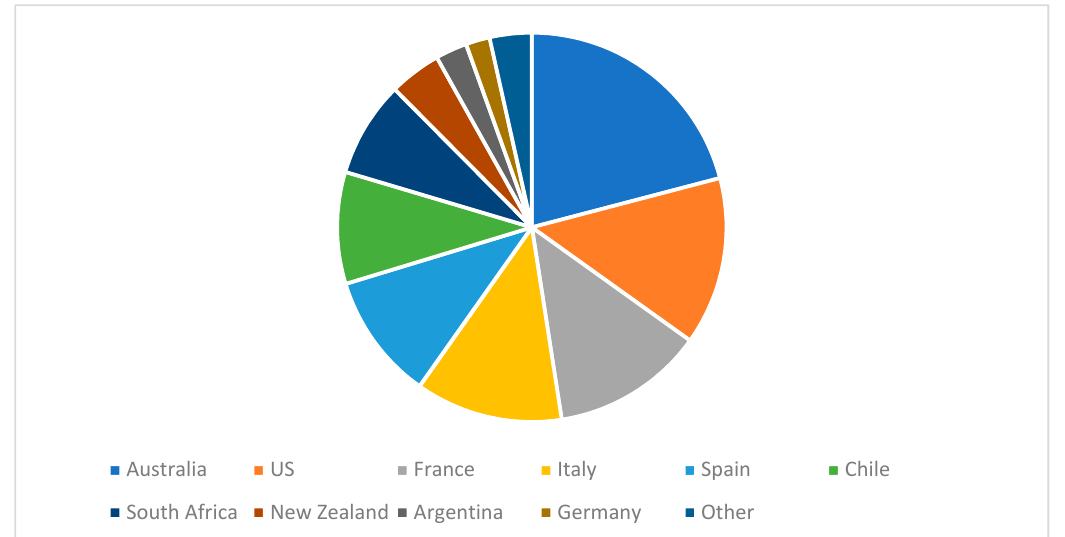
Figure 2. UK still wine consumption by country of origin. Source: Adapted from data supplied by Wine and Spirit Trade Association Market Overview, 2017.